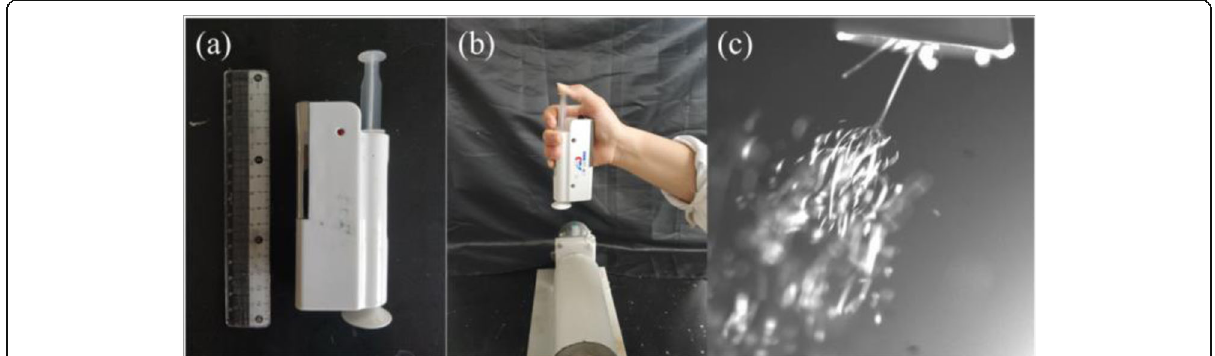
Fig. 1 The handheld electrospinning apparatus ( a ) and the in situ electrospinning process ( b ). The electrospinning jets can be seen from the spinneret ( c )